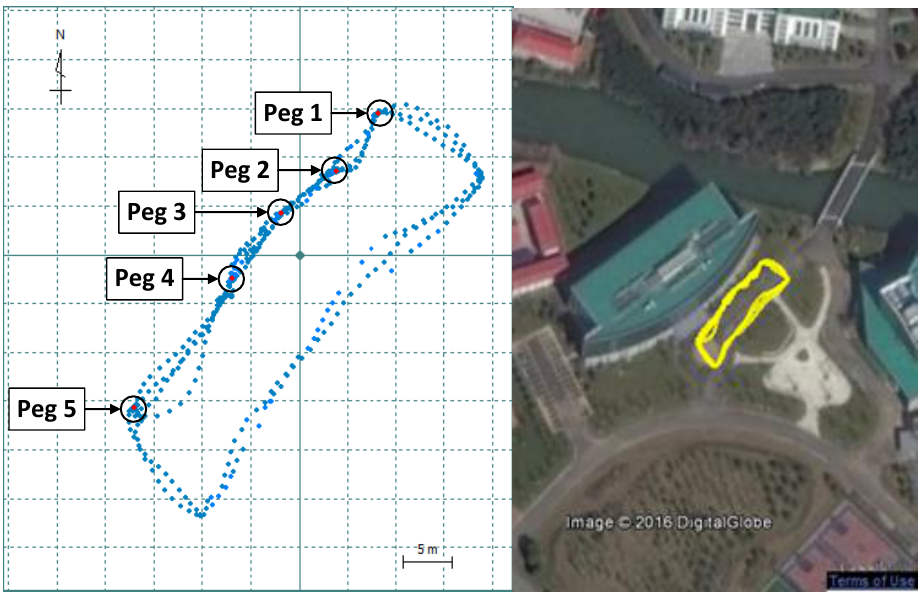
Figure 11. The moving trajectory of antenna and positions of pegs in Dataset KTR2.